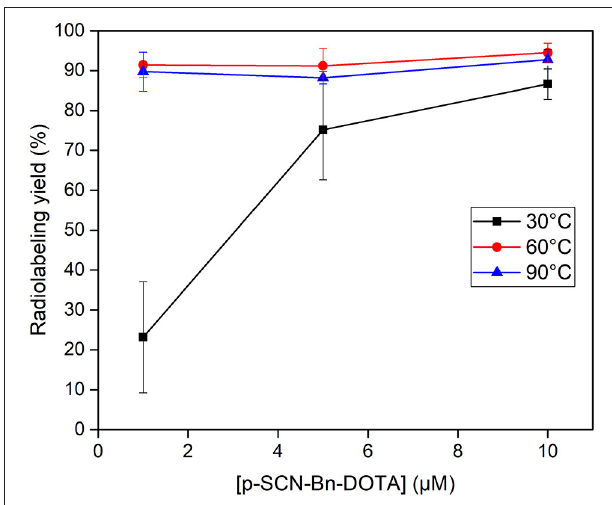
FIGURE 5 | Radiolabeling of 153 Sm with various concentrations of p -SCN-Bn-DOTA at 30 ( ), 60 ( ) and 90 ◦ C ( ) in a 0.1 mol/L NaOAc buffered solution (pH